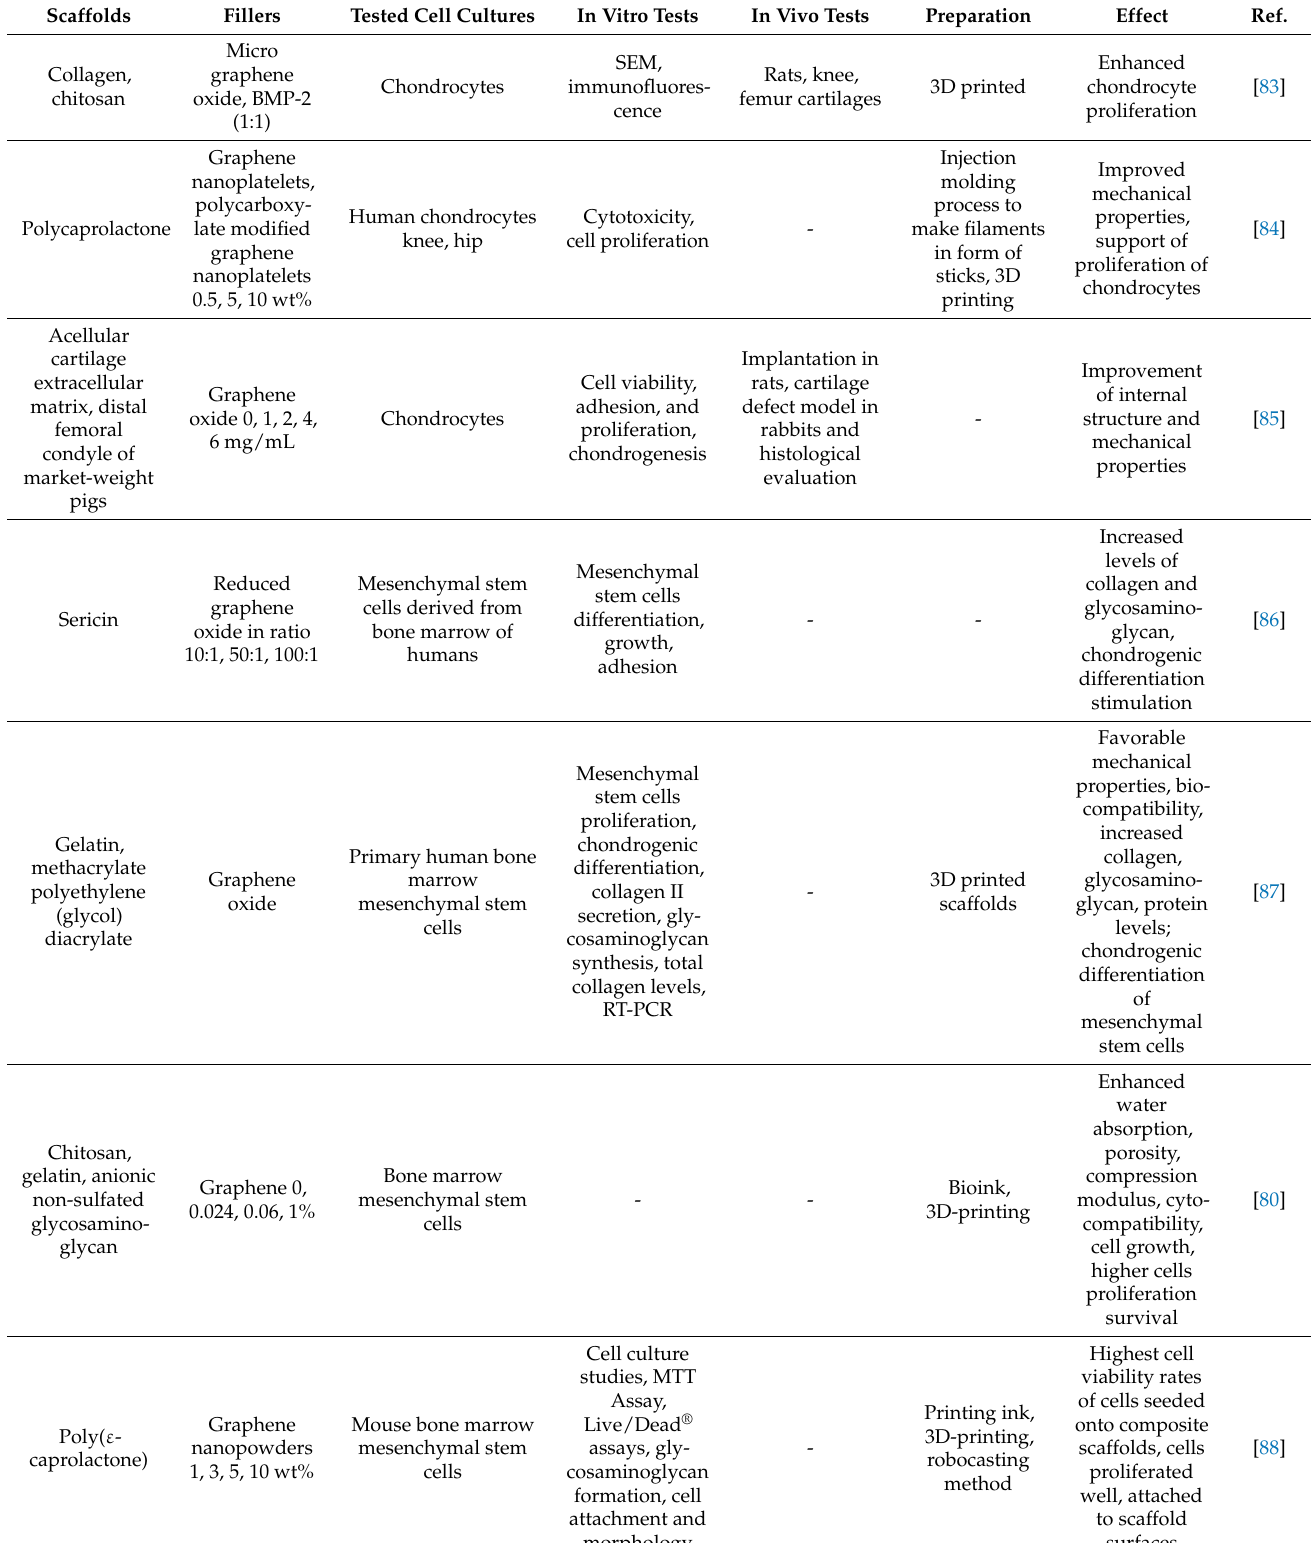
Table 1. Summary of composite nanomaterials developed for cartilage healing and regeneration.